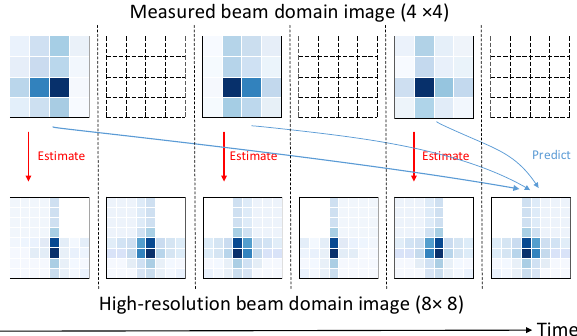
Figure 3. The beam-selection scheme in this paper.